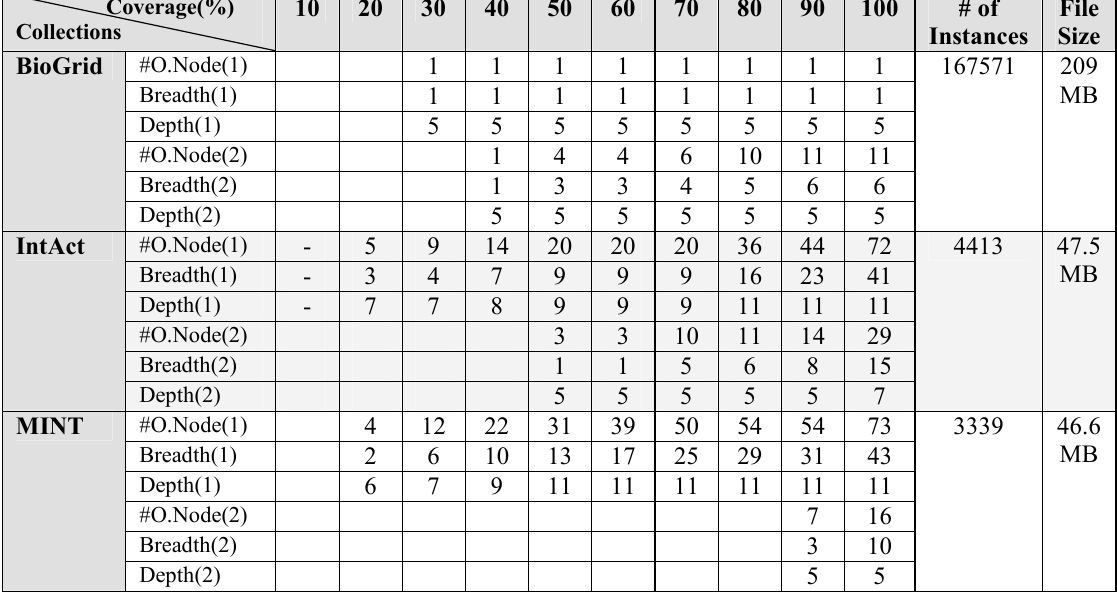
Table 3: Usage of two different set of Optional Nodes in three collections